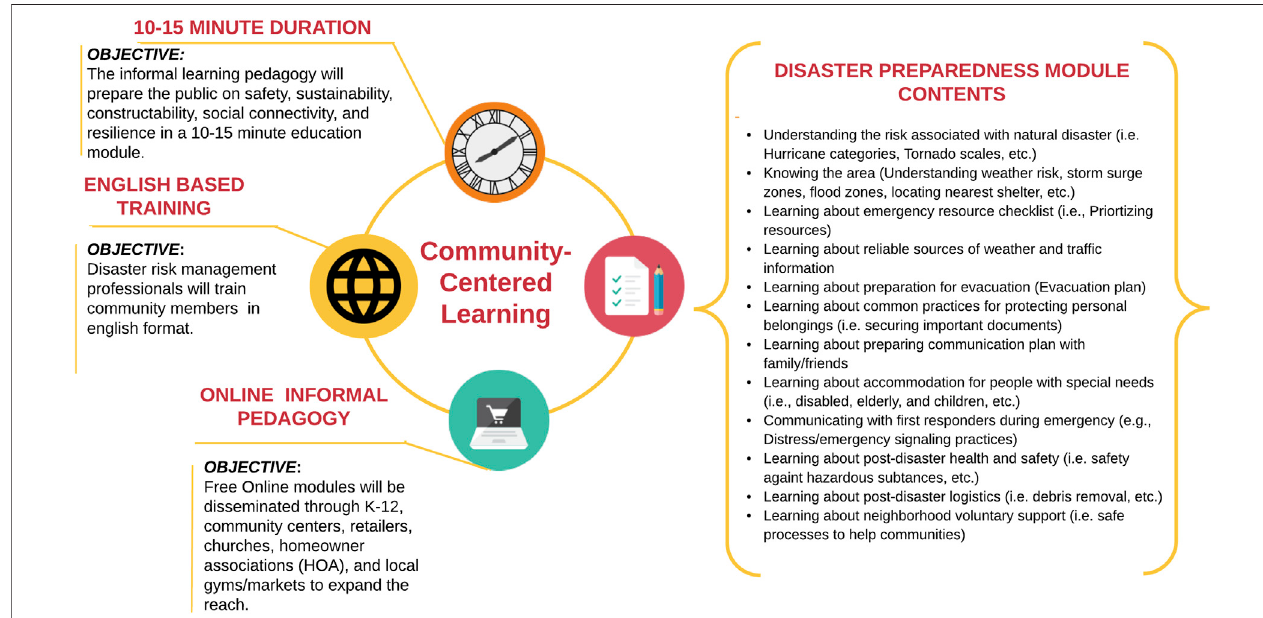
FIGURE 1 | Community-centered informal learning framework for disaster preparedness.